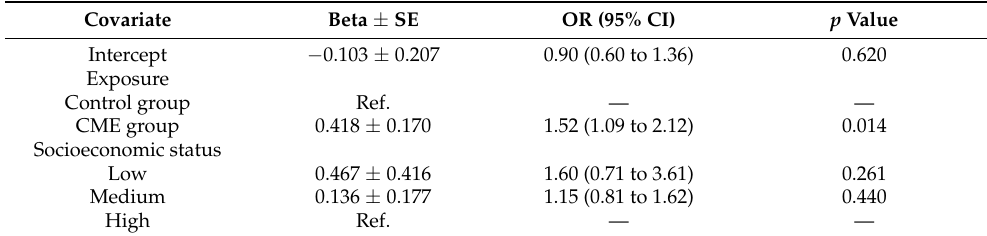
1 Physician site was included in the model as a random effect. Abbreviations: CI, confidence interval; OR, odds ratio; SE, standard